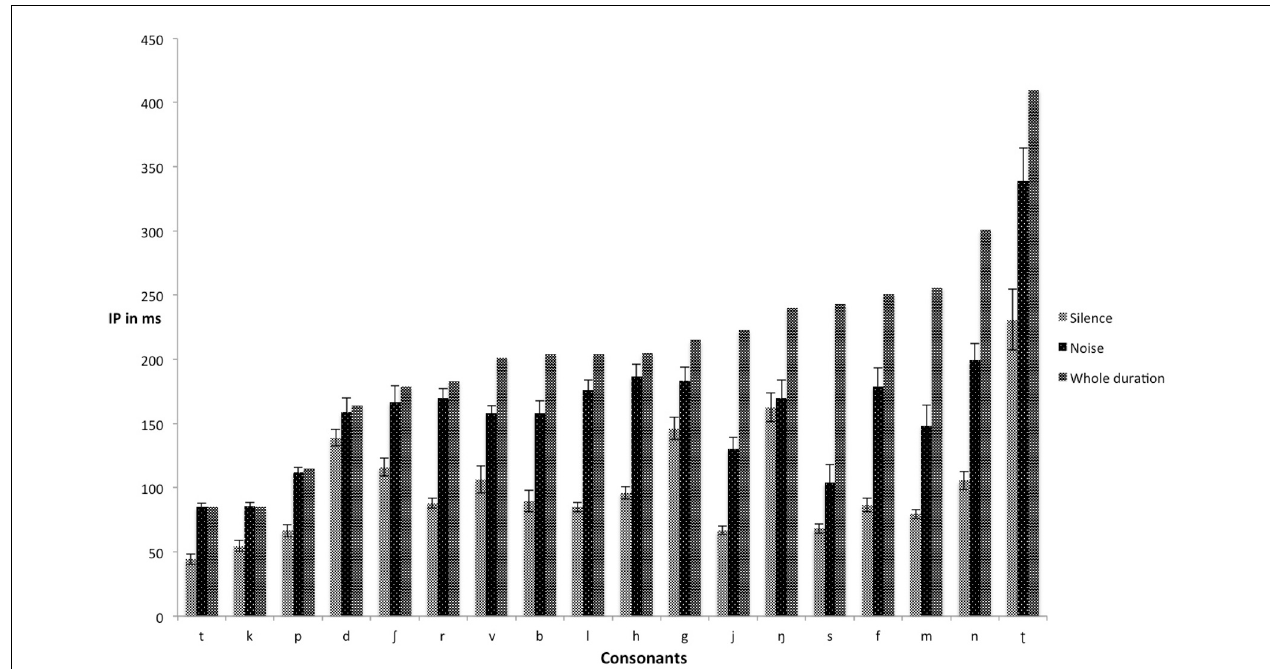
FIGURE 1 | Mean IPs (ms) for consonants in both silence and noise (with accompanying standard errors). IP, isolation point.